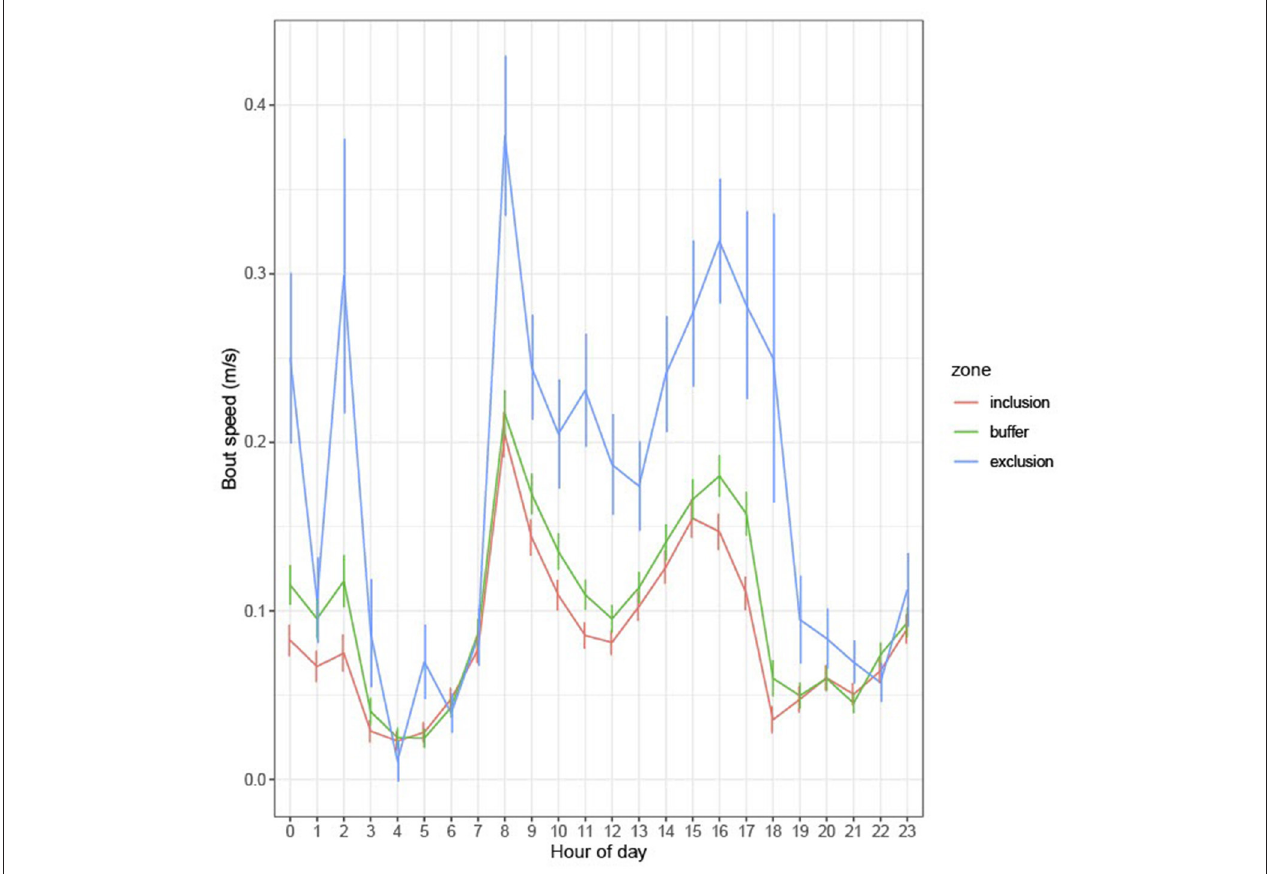
FIGURE 9 | Model-based mean bout speed (m/s) in each zone by hour of all days